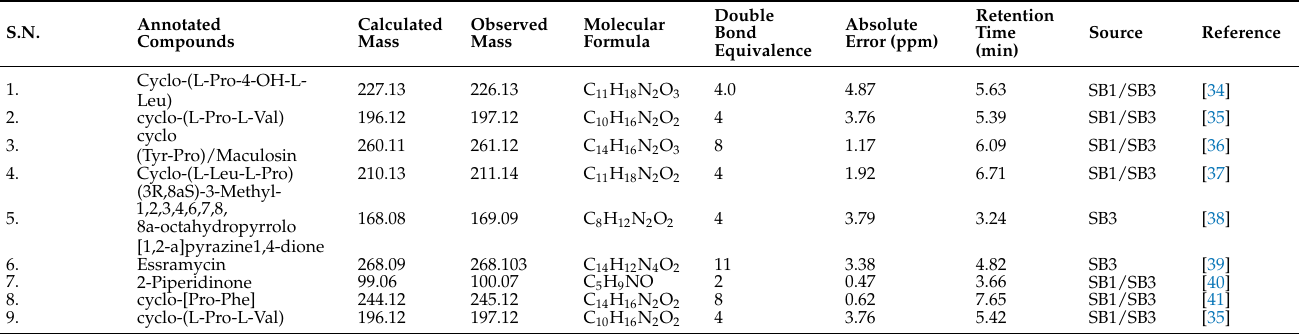
Table 3. Some annotated compounds from the ethyl acetate extracts of S. species SB1 and S. species